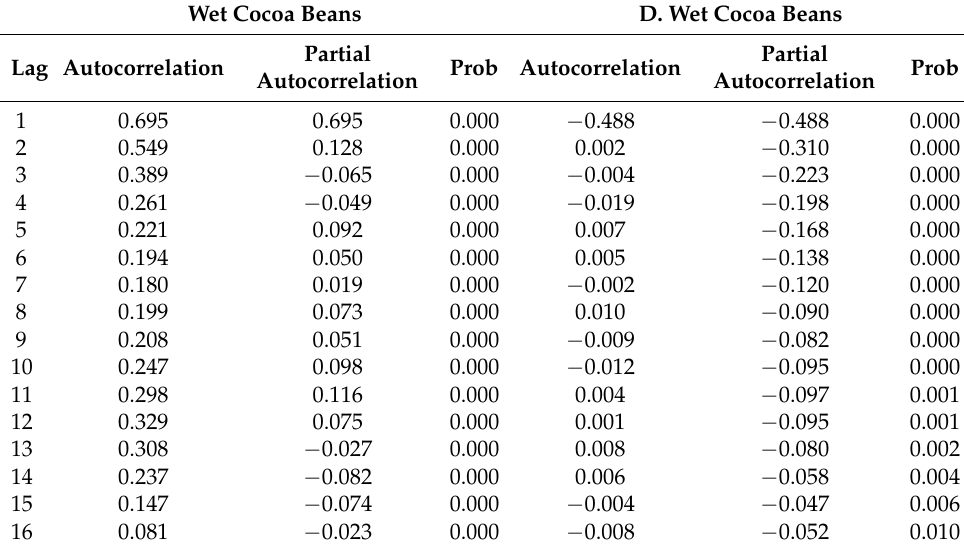
Table 4. ACF and PACF values for Raw and Differenced Wet Cocoa Beans price series. Wet Cocoa